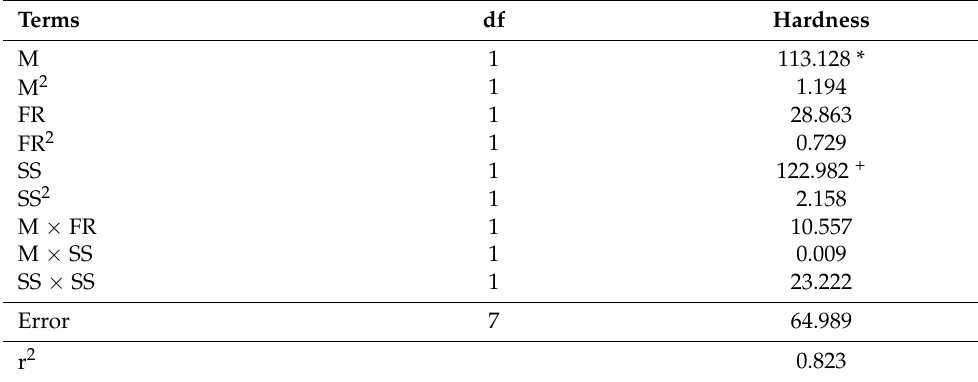
Table 2. Analysis of variance for second-order polynomial for hardness